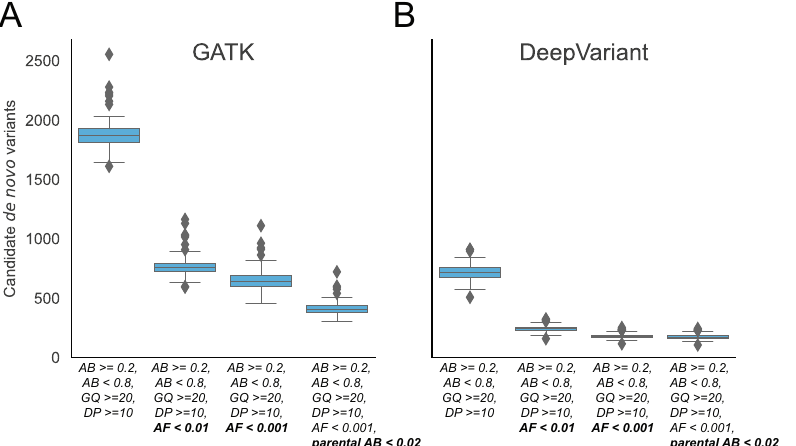
Fig. 4 Candidate autosomal de novo variants per genome identi fi ed by GATK and DeepVariant outside of low-complexity regions. A cohort of 94 WGS trios from the Rare Genomes Project were screened for candidate de novo mutations using GATK ( A ) and DeepVariant ( B ). Variants lying in low-complexity regions were excluded. The leftmost boxplot within each subplot requires a depth ≥ 10, an allele balance between 0.2 and 0.8 along with a genotype quality (GQ) ≥ 20. Lines within the boxplot are determined from the quartiles of the data. The next box requires that the allele frequency in gnomAD is <0.01. The third box lowers the allele-frequency cutoff in gnomAD of <0.001. The fi nal box excludes candidate de novo variants where the allele balance (of the homozygous call) in the parent is ≥ 2%. Supplementary Fig. 13 presents the analogous plots when including low-complexity